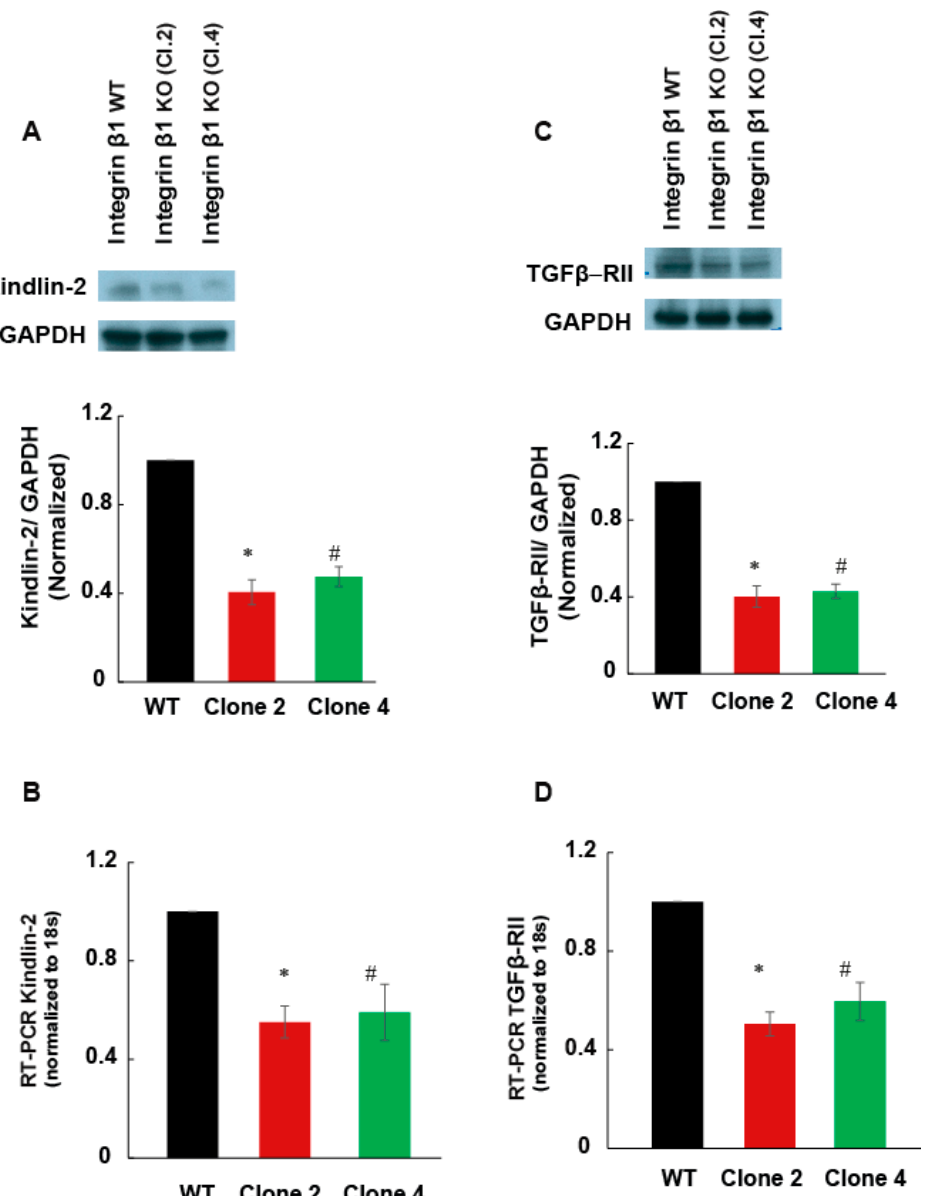
Figure 6. Integrin β 1 deletion downregulated Kindlin-2 and TGF β receptor 2 expression. ( A ) Cell lysate (30 µ